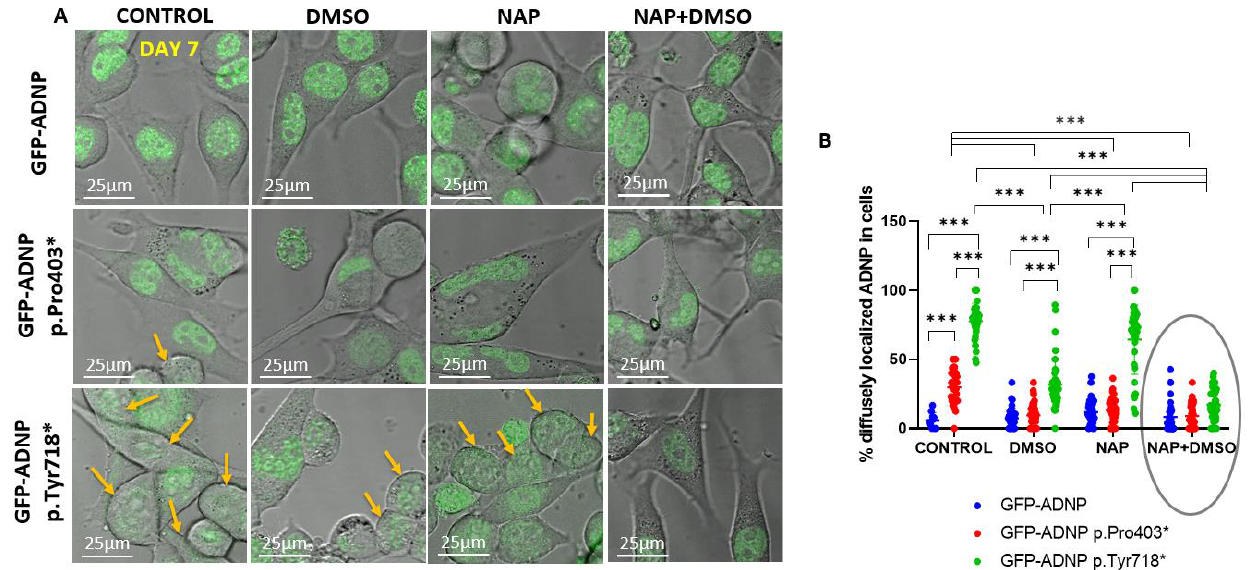
Figure 7. Confocal live cell imaging of neuronal-like differentiated and non-differentiated cells expressing full-length ADNP or truncated ADNP conjugated to GFP, indicating correction of mutant-induced undiscernible nuclear envelopes. ( A , B ) Experiments were conducted as detailed in Figure 6; however, here, the cells used were incubated for 7 days in culture to reach full differentiation. Yellow arrows indicate diffusely distributed mutant ADNP in cells showing indiscernible nuclear/cytoplasmic boundaries. The added ellipse indicates NAP-mediated protection, *** p <